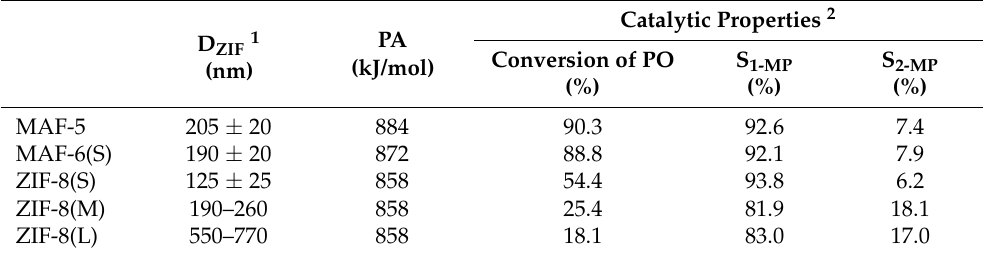
Table 8. Catalytic properties of ZIFs in the synthesis of MP-1 from propylene oxide and